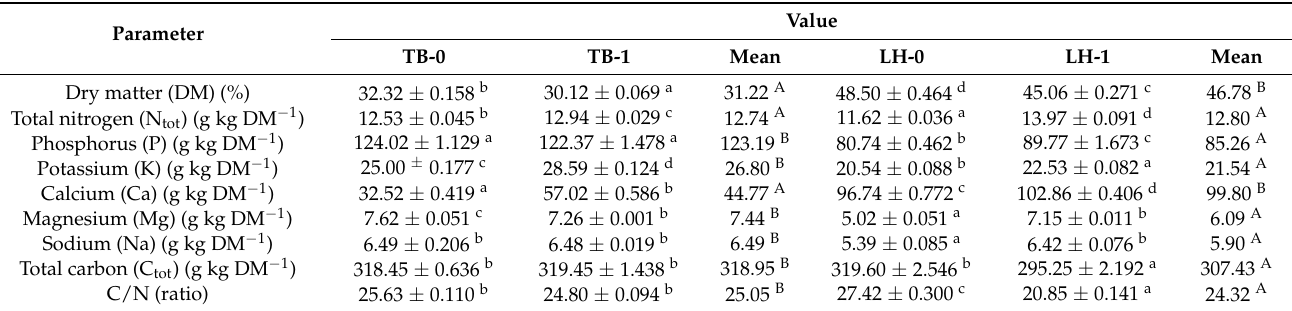
Table 2. Chemical characteristics of poultry manures (PMs).